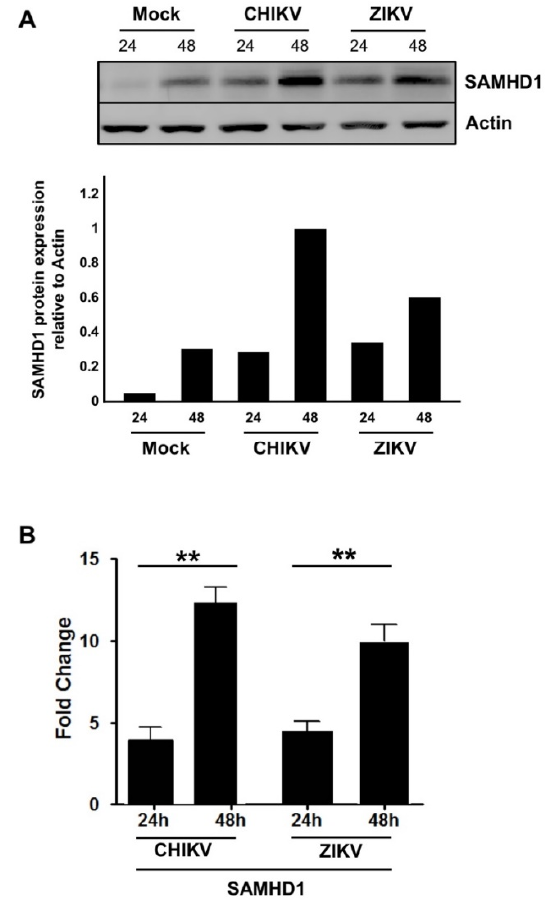
Figure 3. SAMHD1 expression is up-regulated upon CHIKV and ZIKV infection. HFF1 cells were infected with CHIKV or ZIKV at a MOI of 1.0. At 24 or 48 hpi, cells were lysed with TETN-150 and analyzed by immunoblotting using antibodies against SAMHD1 and β -actin Histograms represent relative values of SAMHD1/Actin expression shown in the immunoblot ( A ). Fold change in SAMHD1 expression in virus-infected cells in relation to Mock-infected cells ( B ). The data represent the mean values ± SD from three independent experiments. ** p -value < 0.01, as compared to mock-infected cells.